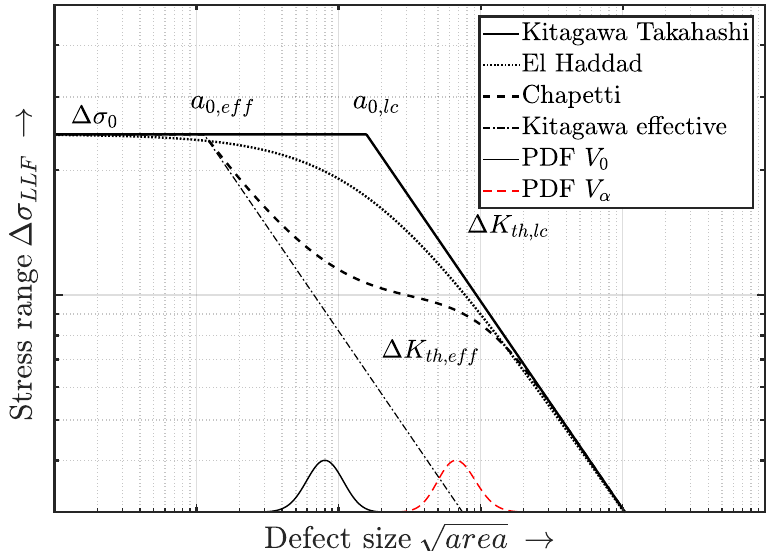
Figure 1. Schematic set up of the Kitagawa Takahashi diagram with its modifications and exemplary defect distributions of a volume V 0 and an enhanced volume V α